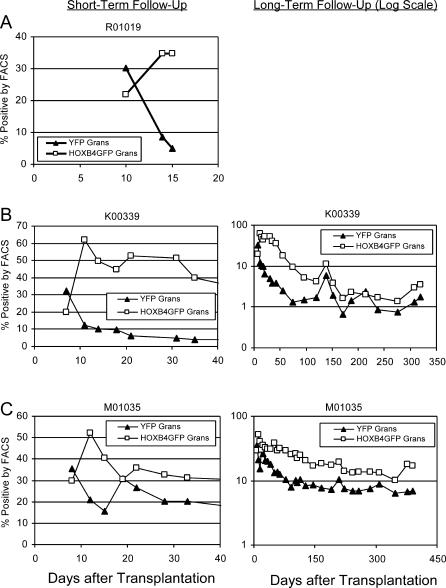
Improved Engraftment of HOXB4GFP-Transduced CD34
+ Cells
Equal numbers of macaque CD34
+ cells were transduced in 3-d transduction cultures with either the HOXB4GFP- or YFP-expressing vector. Transduced cells were infused into myeloablated animals. The percentage of HOXB4GFP
+ and YFP
+ granulocytes was assessed by flow cytometry. Shown is the engraftment of HOXB4GFP
+ and YFP
+ granulocytes after transplantation.